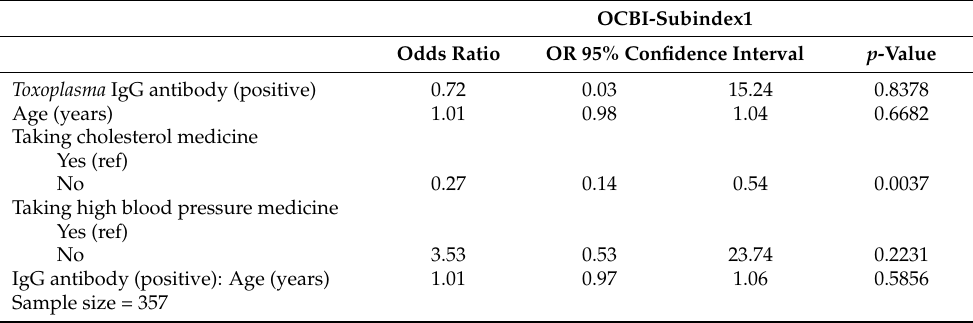
Table 11. Ordinal logistic regression model for the OCBI-Subindex1 on T. gondii IgG antibody (positive/negative) adjusted for medications